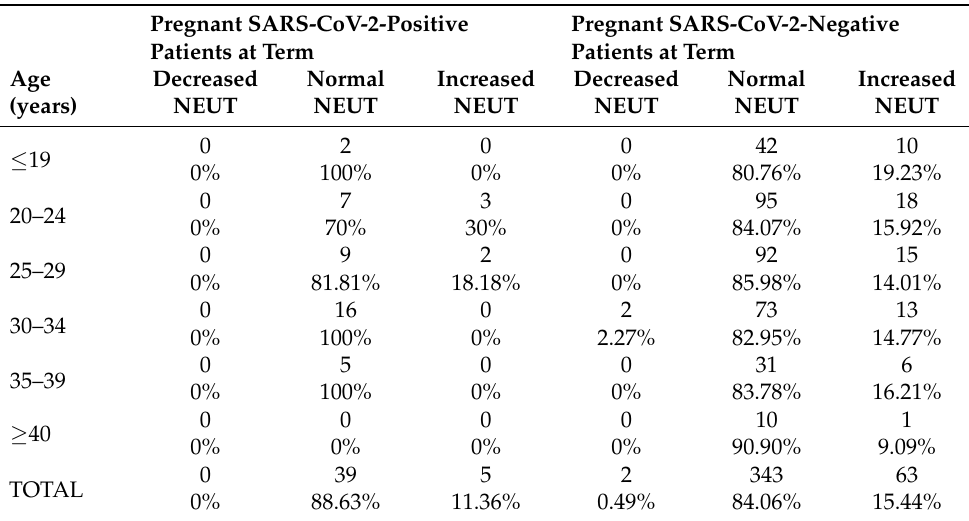
Table 9. Number and percent of pregnant patients with a normal, increased (neutrophilia), and decreased (neutropenia) number of neutrophils (NEUT) by age group.